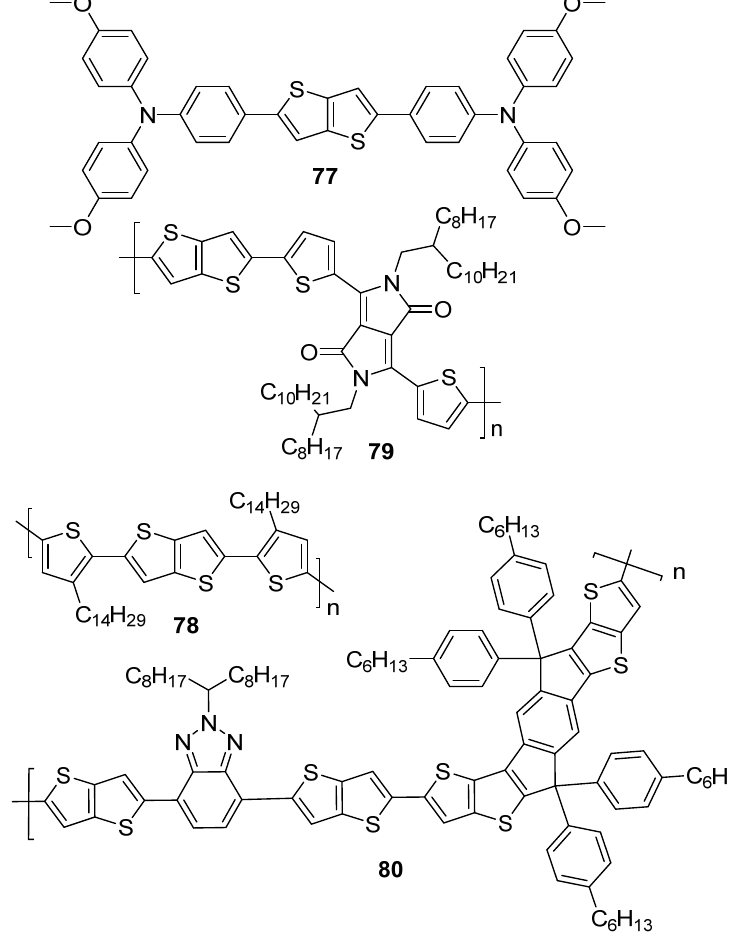
Figure 10. Hole-transporting TT derivatives for the Perovskite solar cells. TT 2 can be also utilized in materials for Perovskite solar cells. For instance, the symmetrical compound 81 (Figure 11), bearing the thieno[2,3- b ]thiophene central scaffold with four peripheral 4-[bis(4-methoxyphenyl)amino]phenyl substituents, has been used as HTM [62]. The latter moiety is a typical structural feature of Spiro-OMeTAD—the most common HTM used in PSCs [63]. As compared to the aforementioned TT 1 derivatives 77 – 80 (Table 7), the PCE and FF values of 81 (18.78% and 76.2%) are significantly higher.